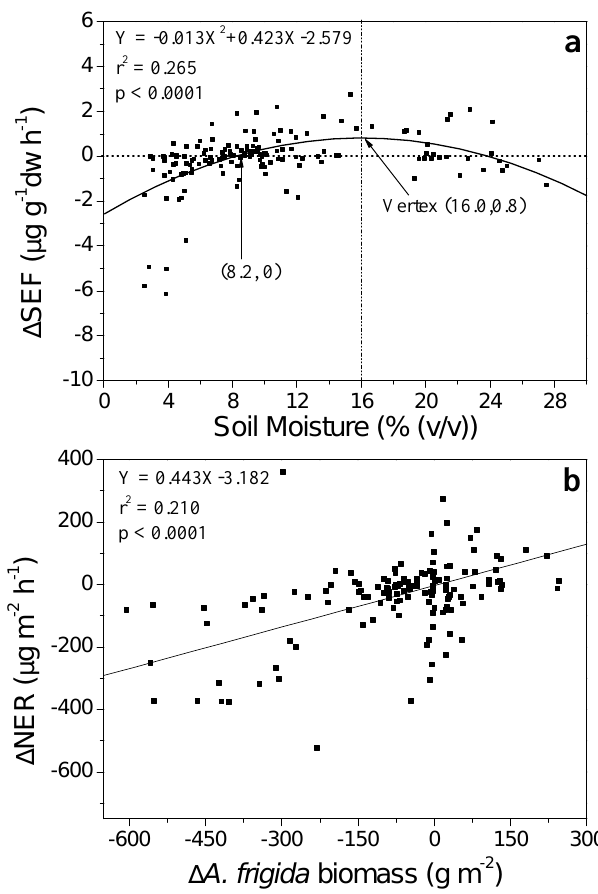
Fig. 5. Relationship between a warming-induced change in stan- dard monoterpene emission factor (SEF) and soil moisture, and between N-induced changes in natural monoterpene emission rate (NER) and N-induced changes in Artemisia frigida biomass. The treatment-induced changes of each variable were determined by the value in warming or N addition site minus the mean in non-warming or non-N-addition